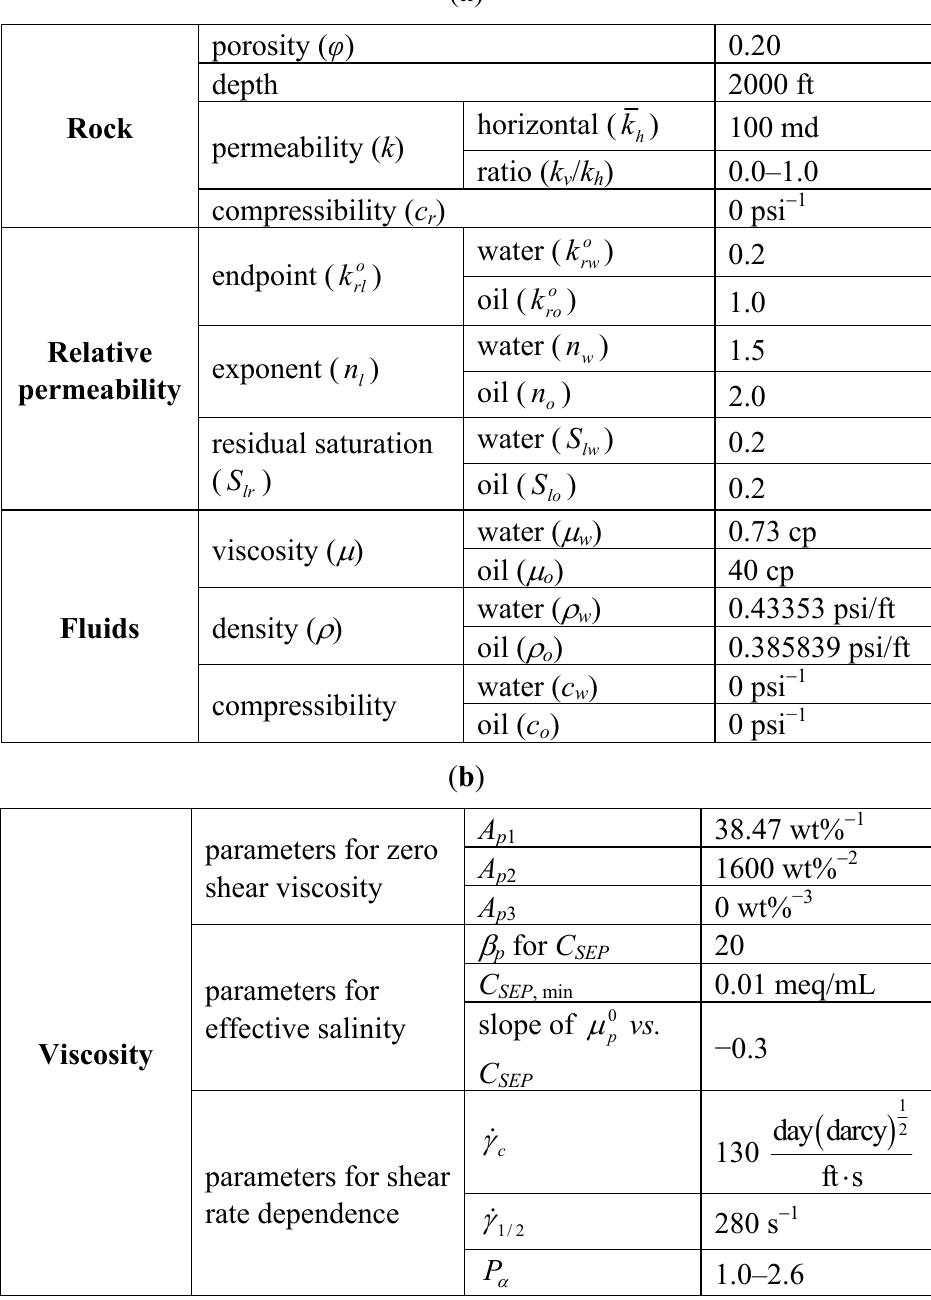
Table 2. Input parameters for simulation. ( a ) properties of reservoir rock and fluids; ( b ) polymer